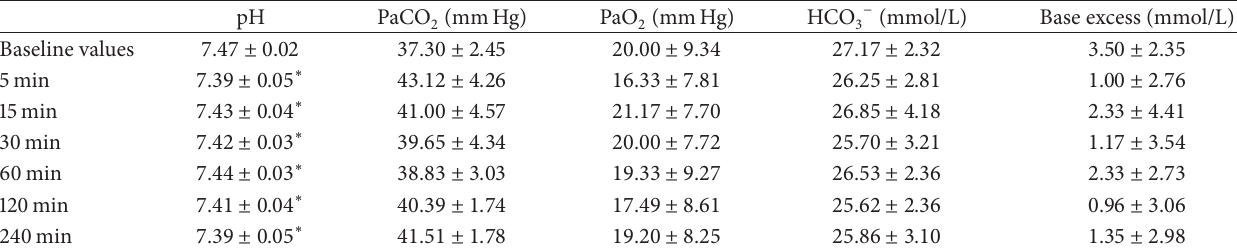
Table 4: Changes in foetal acid-base variables following maternal administration of a single intravenous bolus of 2mg/kg of alfaxalone in a 2-hydroxypropyl- 𝛽 -cyclodextrin formulation (mean ±